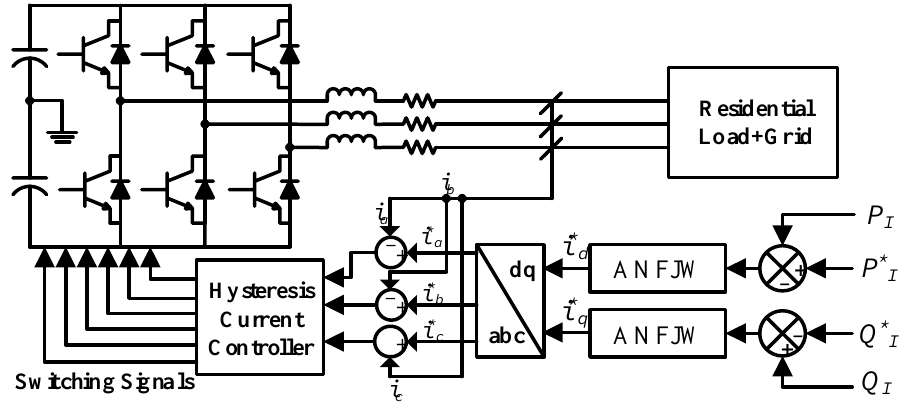
Figure 5. Working of the proposed strategy.